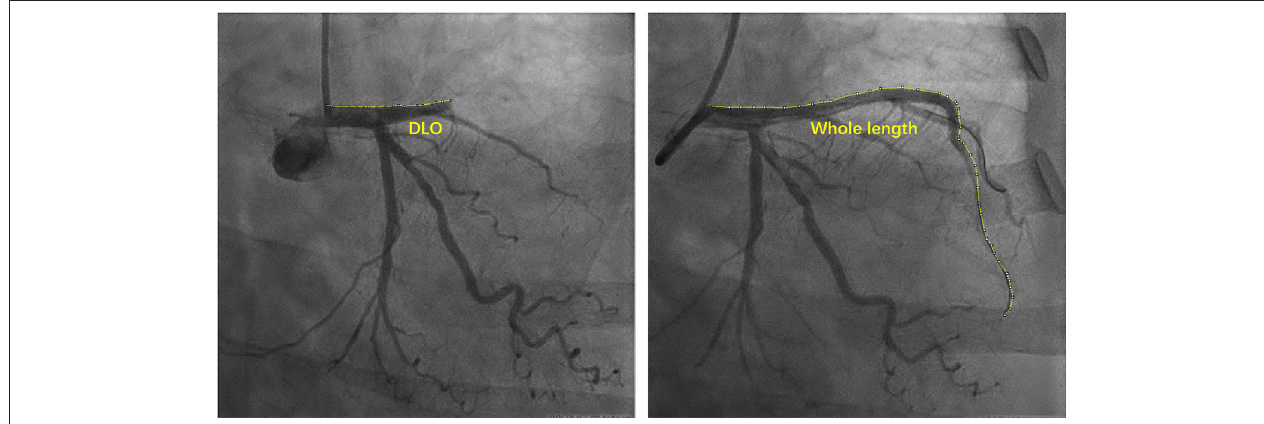
FIGURE 1 | Schematic diagram of measuring curve length of coronary artery. DLO, distance from lesion to ostia.